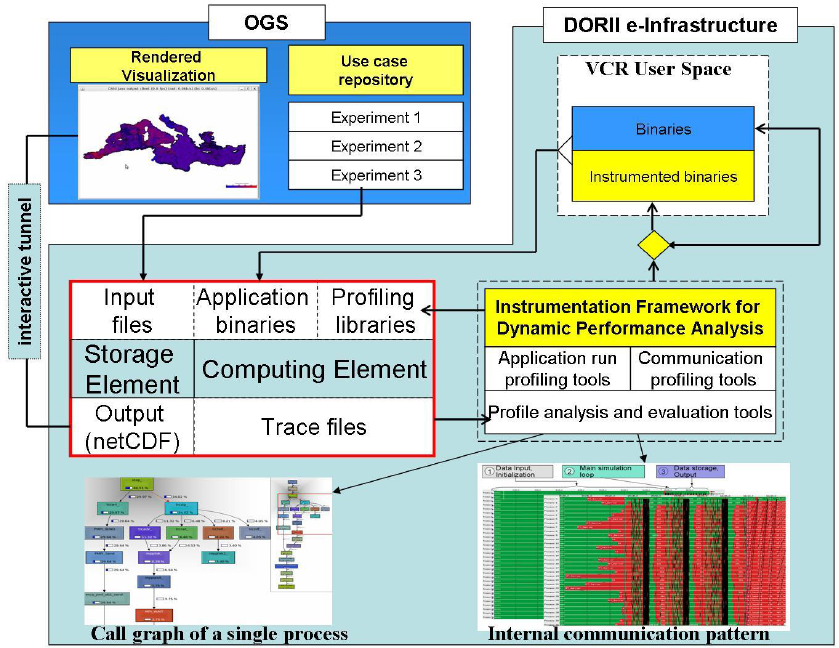
Figure 2. Framework of analysis of the OPATM-BFM integrated in the DORII e-Infrastructure. A snapshot of the visualization of model’s output is showed in the top-left corner.